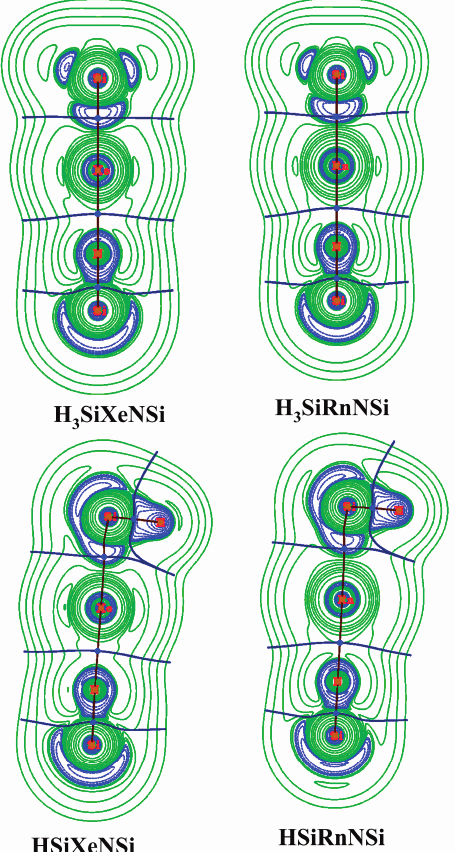
Figure 2. Contour plots of the Laplacian of the electron density of H 3 SiXeNSi and HSiXeNSi clusters at a particular plane computed at the MP2/def2-QZVPPD/WTBS level (WTBS is used for Xe and Rn; The green-colored region shows the area of ∇ 2 ρ ( r ) > 0, whereas the blue-colored region shows the area of ∇ 2 ρ ( r ) <